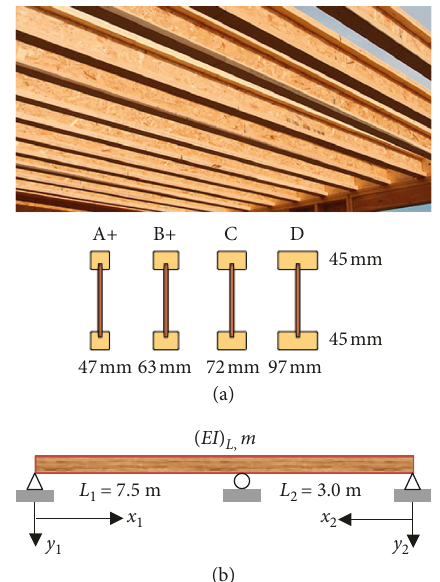
Figure 11: A two unequal span floor constructed from I -joists with pinned ends. (a) A two unequal span floor constructed with JJI 400D joists. (b) A two unequal span floor with pinned ends and α (cid:30)